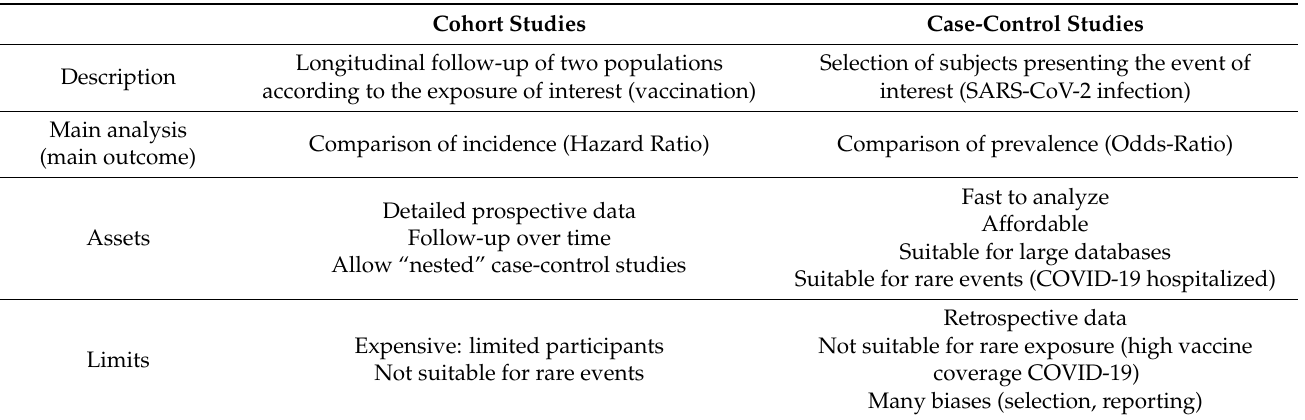
Table 1. Summary of methods for measuring real-life effectiveness in the context of COVID-19